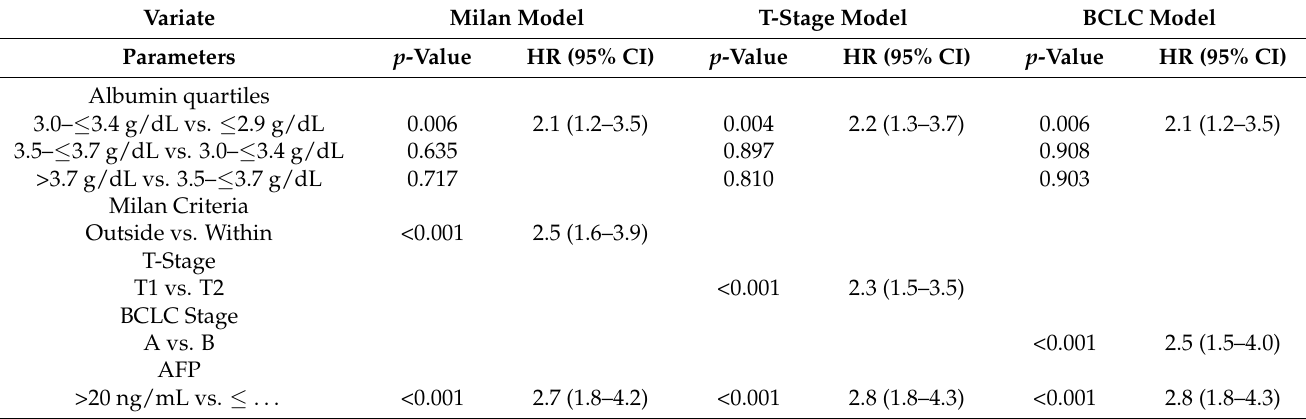
Figure 2. Study Cohort Overall Time to Progression Curve. Kaplan–Meier curve of the percentage of patients without hepatocellular carcinoma progression as a function of time after first cycle liver- directed therapy (LDT). Censored data is marked with a vertical upward dash. The total number of patients remaining in the analysis at each major x-axis time point is listed in the table below the plot. Interquartile range (IQR). Table 2. Multivariate analysis of time to progression by albumin